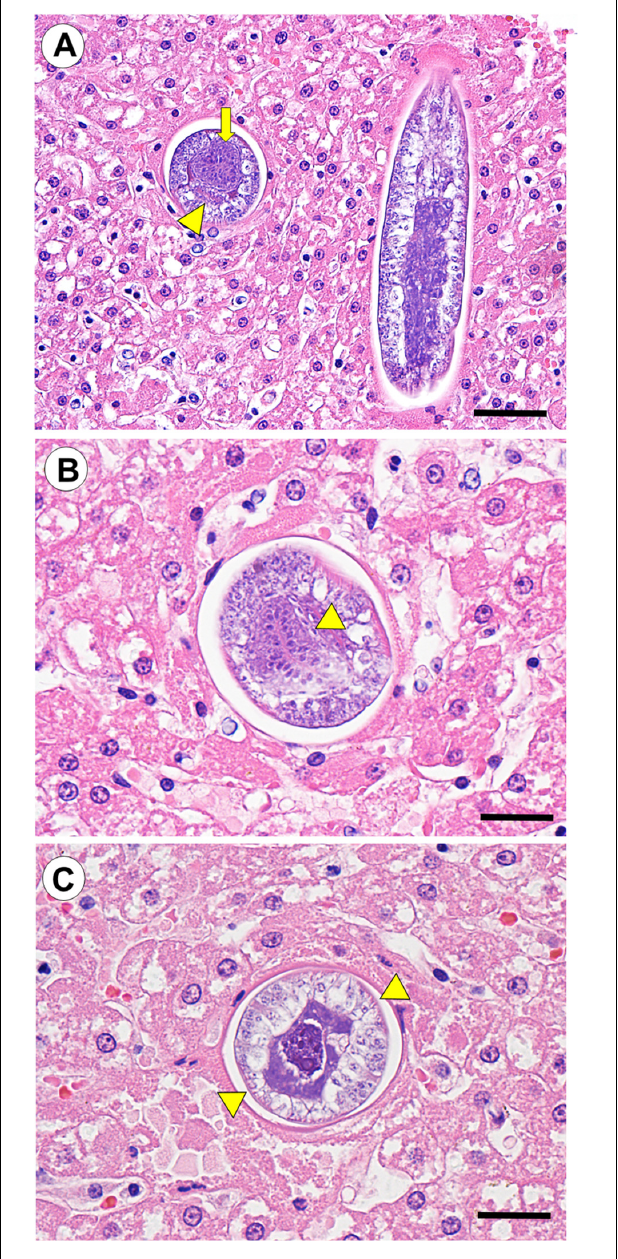
FIGURE 3 | (Case 3): Larval nematode profiles (putative C. hepatica larvae) in the hepatic parenchyma of a southern sea otter ( Enhydra lutris nereis ). (A) Serial 5 µ m thick tissue sections revealed multiple cross-sectional, oblique, and longitudinal nematode profiles that were clustered in a small area of the hepatic parenchyma. Cross-sections of these parasites showed single round to oval intestinal (broad arrow) and gonadal (arrowhead) profiles (hematoxylin and eosin stain. Bar = 100 µ m). (B,C) The nematodes were 105–120 µ m diameter and coelomate with a cuticle, a prominent stichosome surrounding the esophagus (indicated by arrowhead in B ), and paired hypodermal bands (indicated by arrowheads in C ); these morphological characteristics are indicative of C. hepatica . The gonads were small with no visible ova or spermatozoa, and no eggs were visible in the adjacent hepatic parenchyma, suggesting that the parasites were immature (hematoxylin and eosin stain. Bar = 50 µ m for both B,C